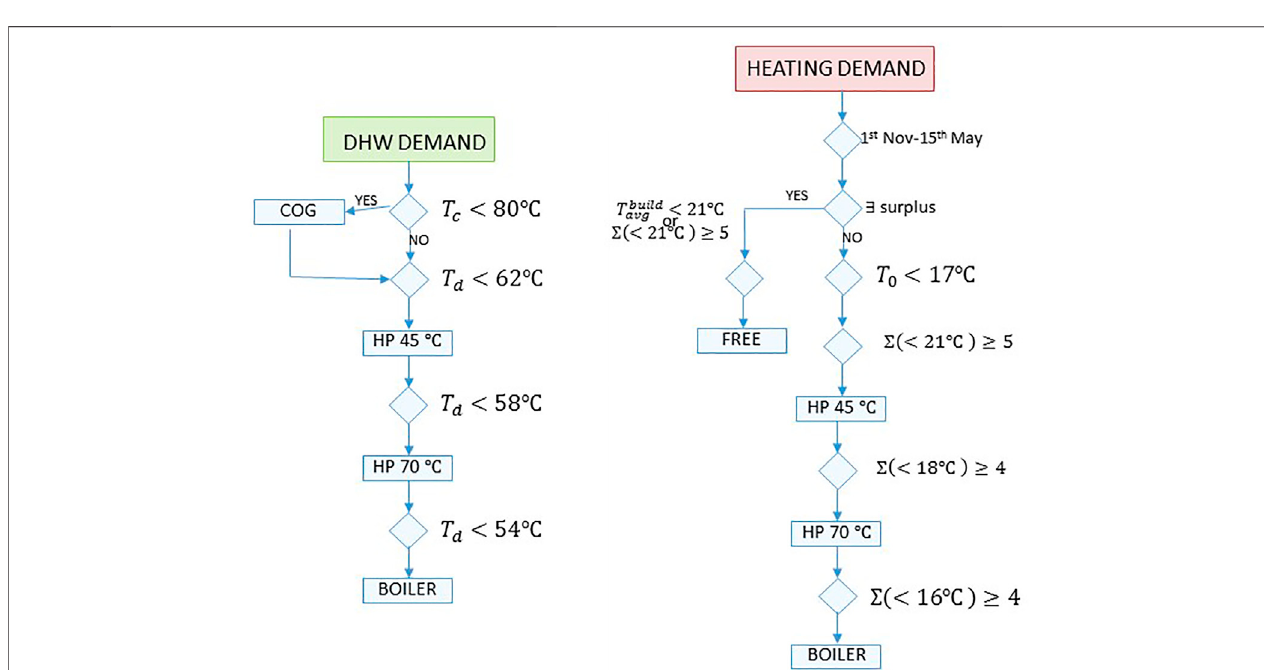
FIGURE 4 | System control logic fl